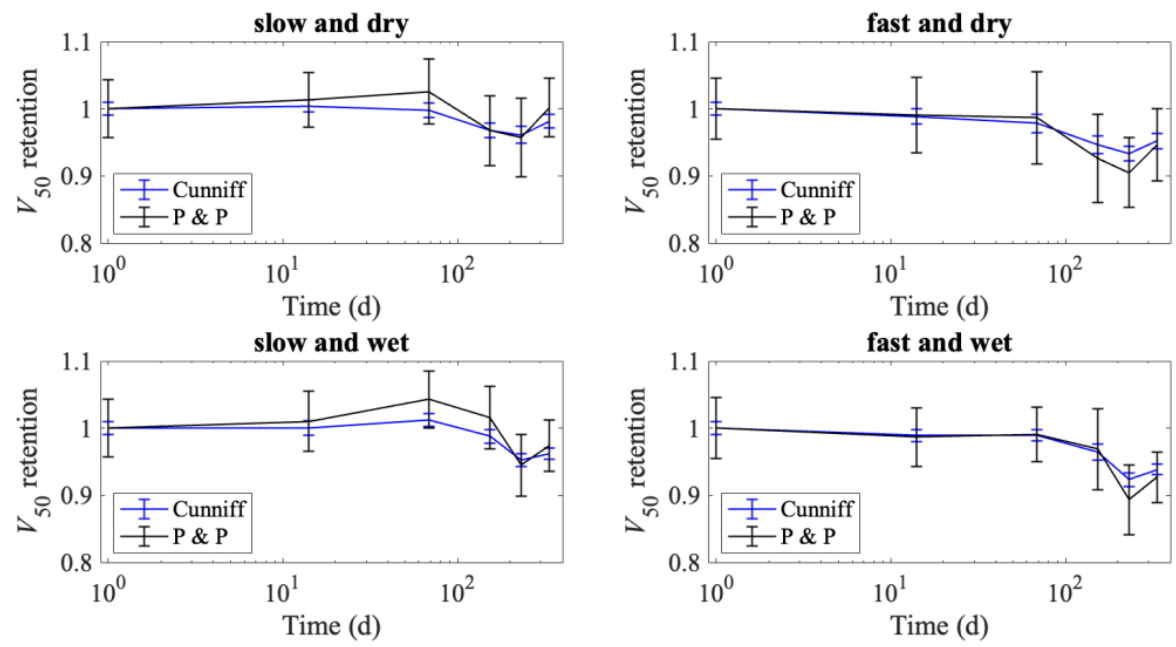
Figure 13. V 50 retention plots to illustrate the potential impact of aging on the predicted ballistic limit retention for this